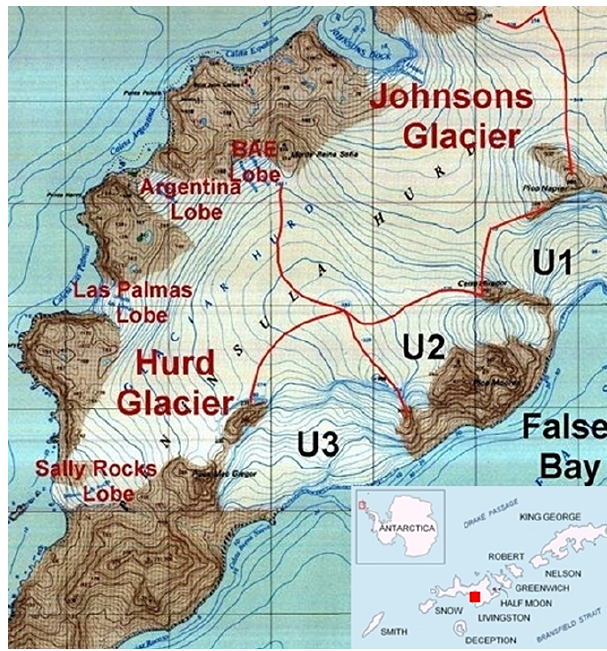
Figure 1. Location of Johnsons and Hurd glaciers in Hurd Penin- sula. Base map: 1 : 25000 map from Geographic Service of the Army (Spain), 1991. The inset shows the location of the South Shet- land Islands, and Livingston Island in particular. The red rectangle in the inset indicates the location of Hurd